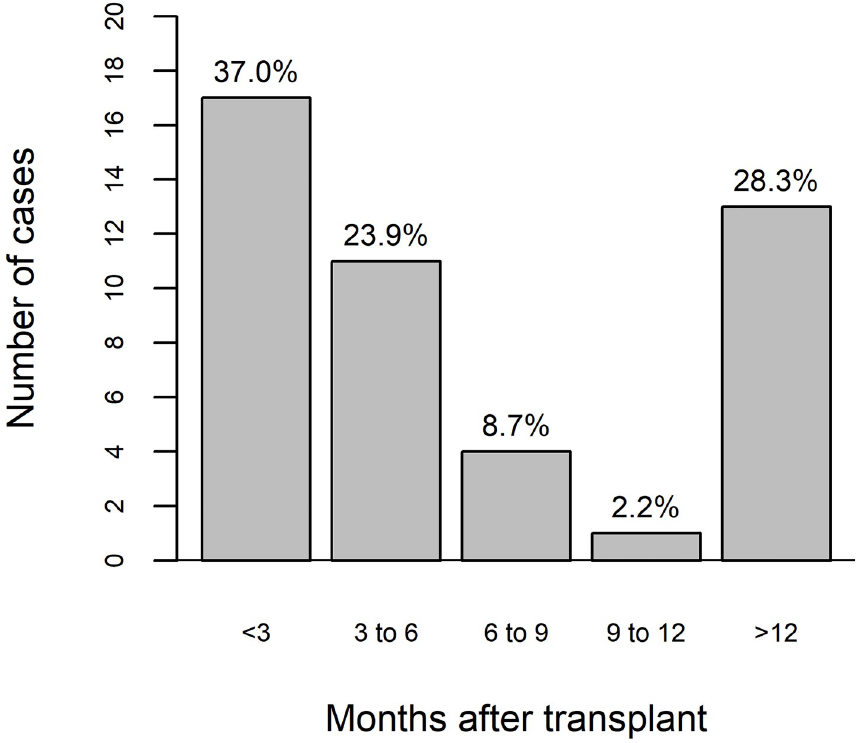
Fig 1. Temporal distribution of severe Strongyloides stercoralis infection after kidney